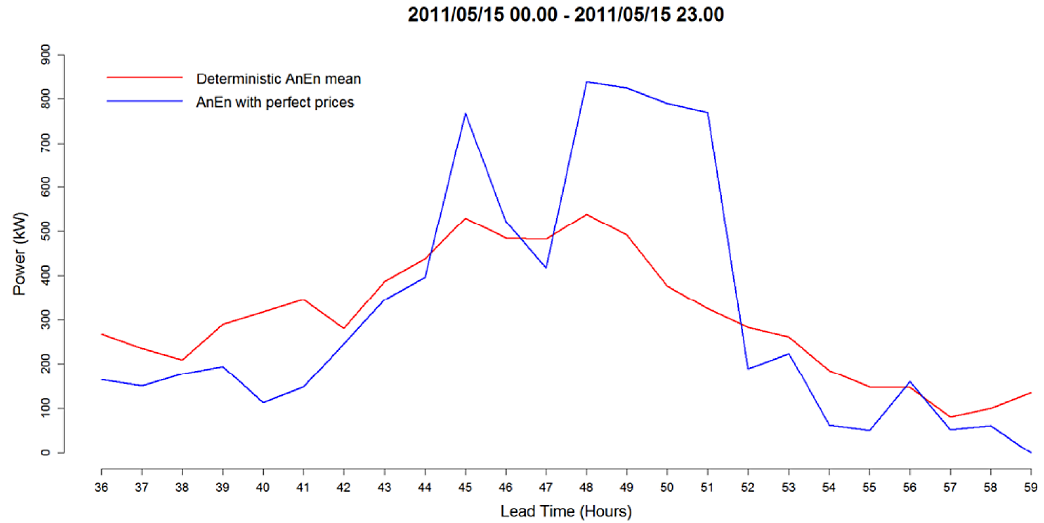
Figure 2. Hourly time-series as a function of forecast lead time of the deterministic forecast provided by AnEn mean (red), and optimal quantile forecast (blue) chosen, in the case of perfect prices forecast, by using the PDF of AnEn in the Eq.